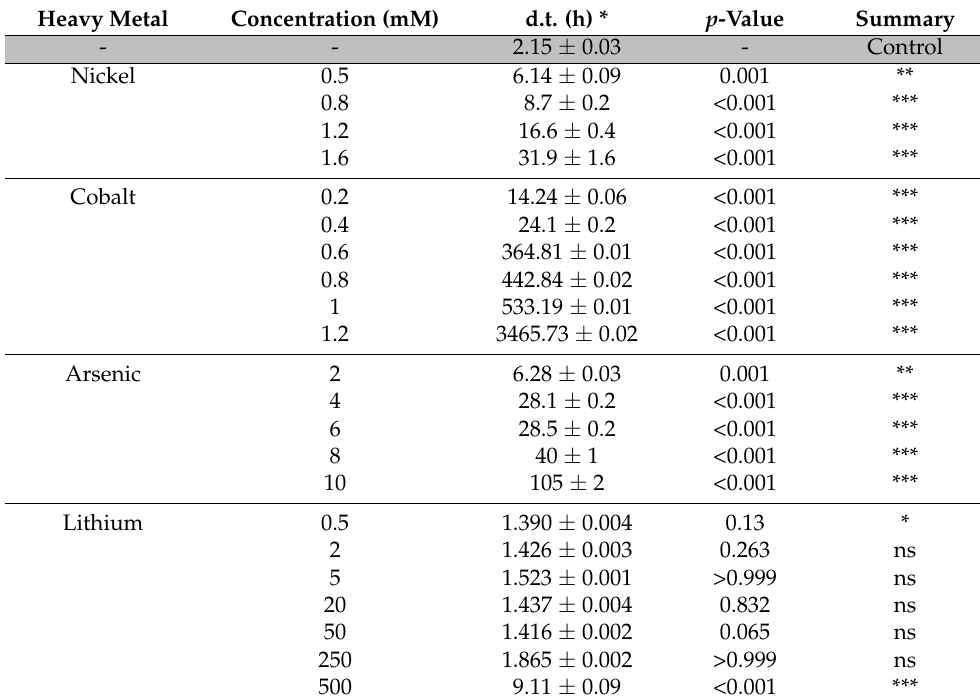
Table 5. Doubling time of Hfx. mediterranei growth in the presence of Ni, Co, As, or Li at different con-